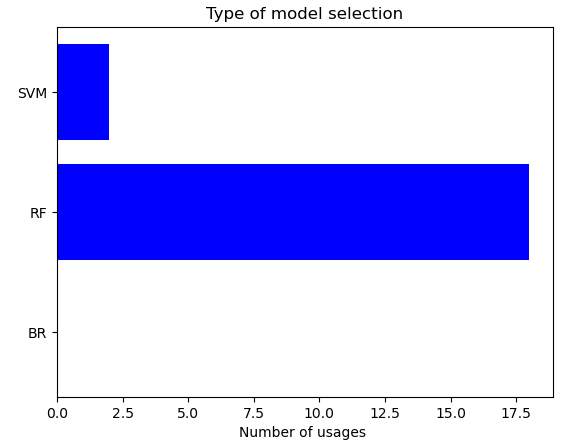
Figure 16. Type of model selection for the magnetic